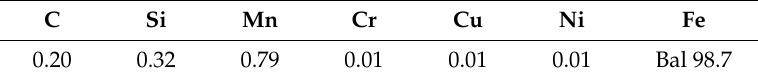
Table 5. Chemical composition of mild steel (wt